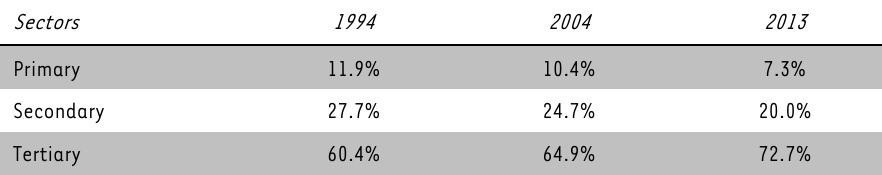
Source: Culled from Du Plessis & Smit (2006) and ALMB